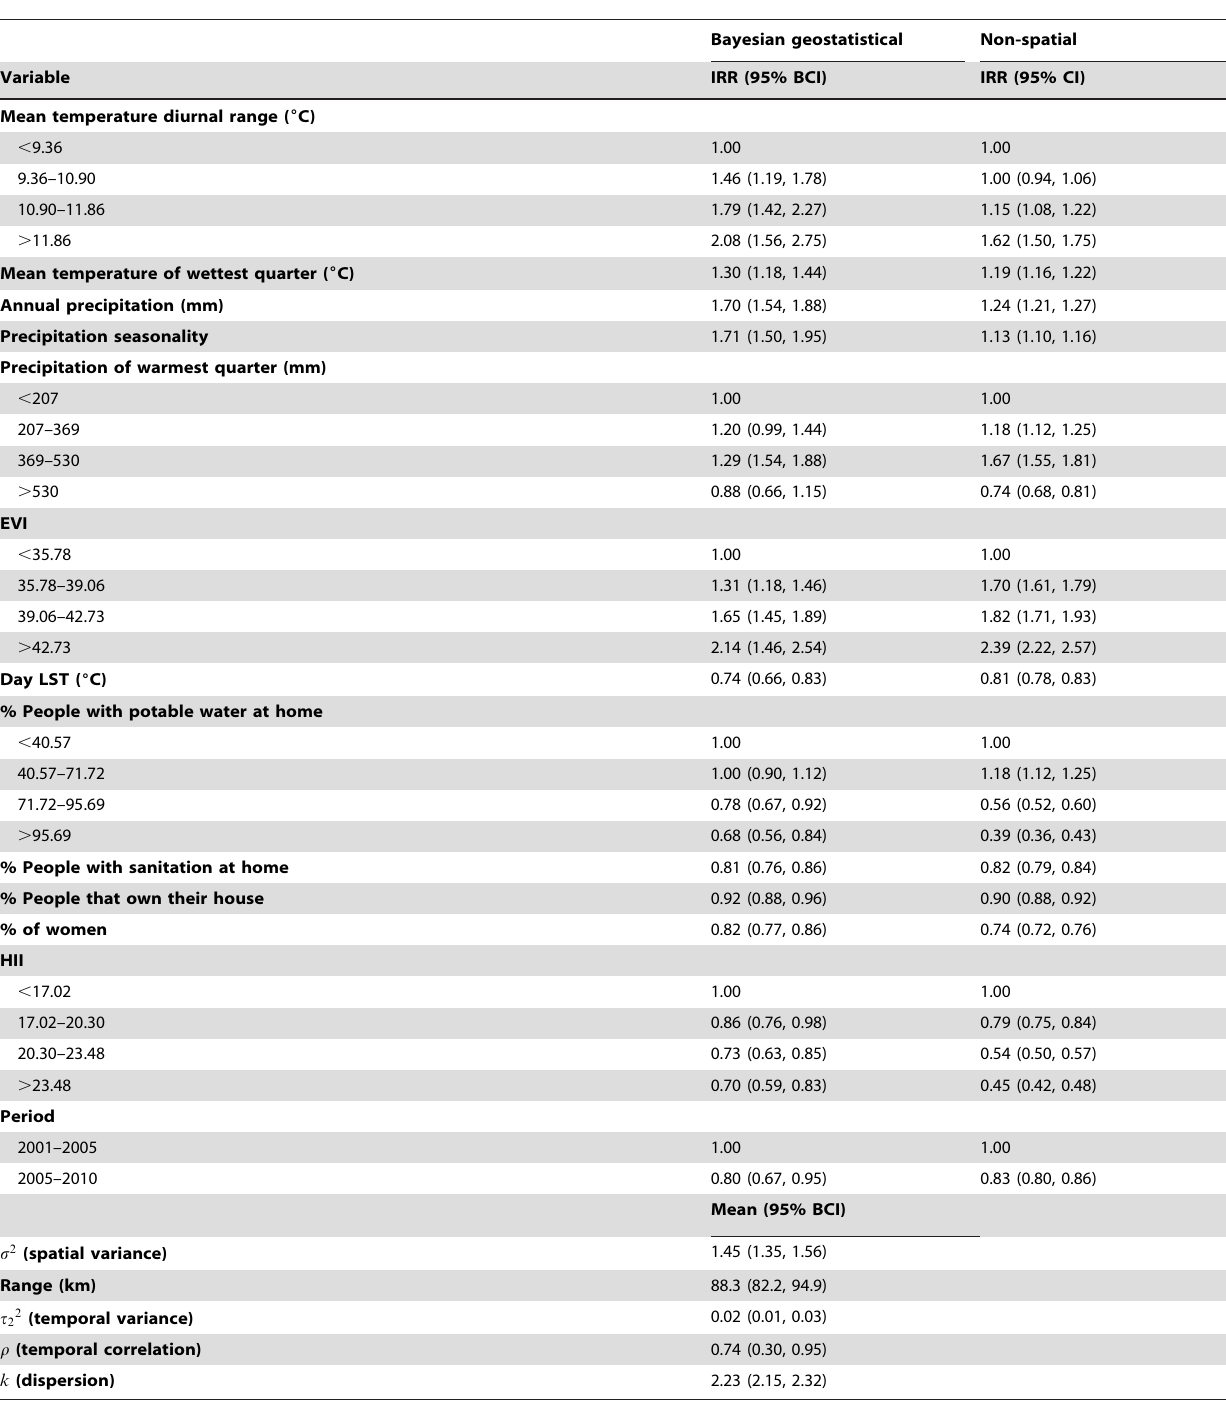
Table 3. Parameter estimates for cutaneous leishmaniasis (CL) in Brazil for